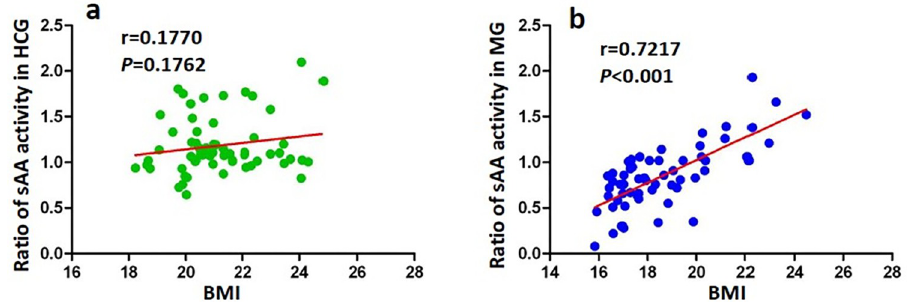
Fig 3. Spearman correlation analysis between the ratio of sAA activity and BMI in HCG (a) and MG patients (b).